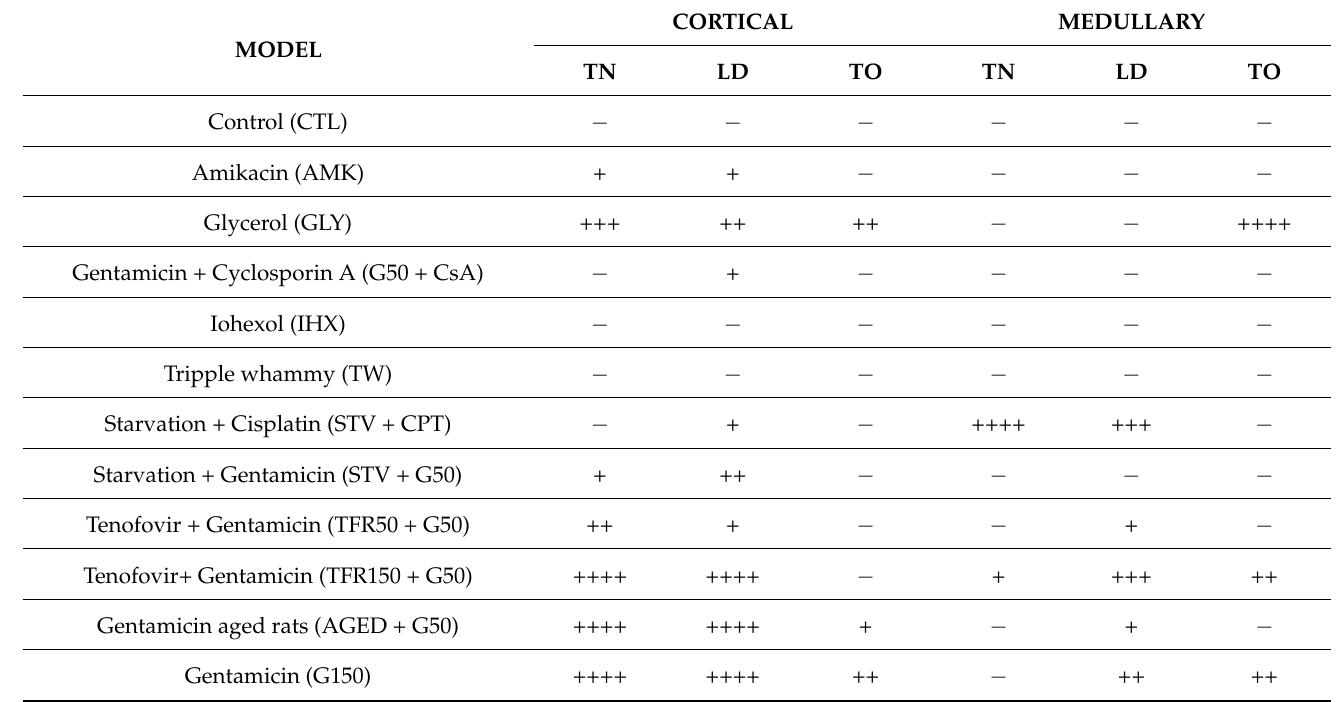
Table 1. Renal histology of the AKI models. Typical renal cortical and medullary findings of the AKI models included in the study. LD: luminal debris. TN: tubular necrosis. TO: tubular obstruction. − : Normal histology (i.e., no pathological findings). Severity scale: +: low. ++: medium. +++: high. ++++: very